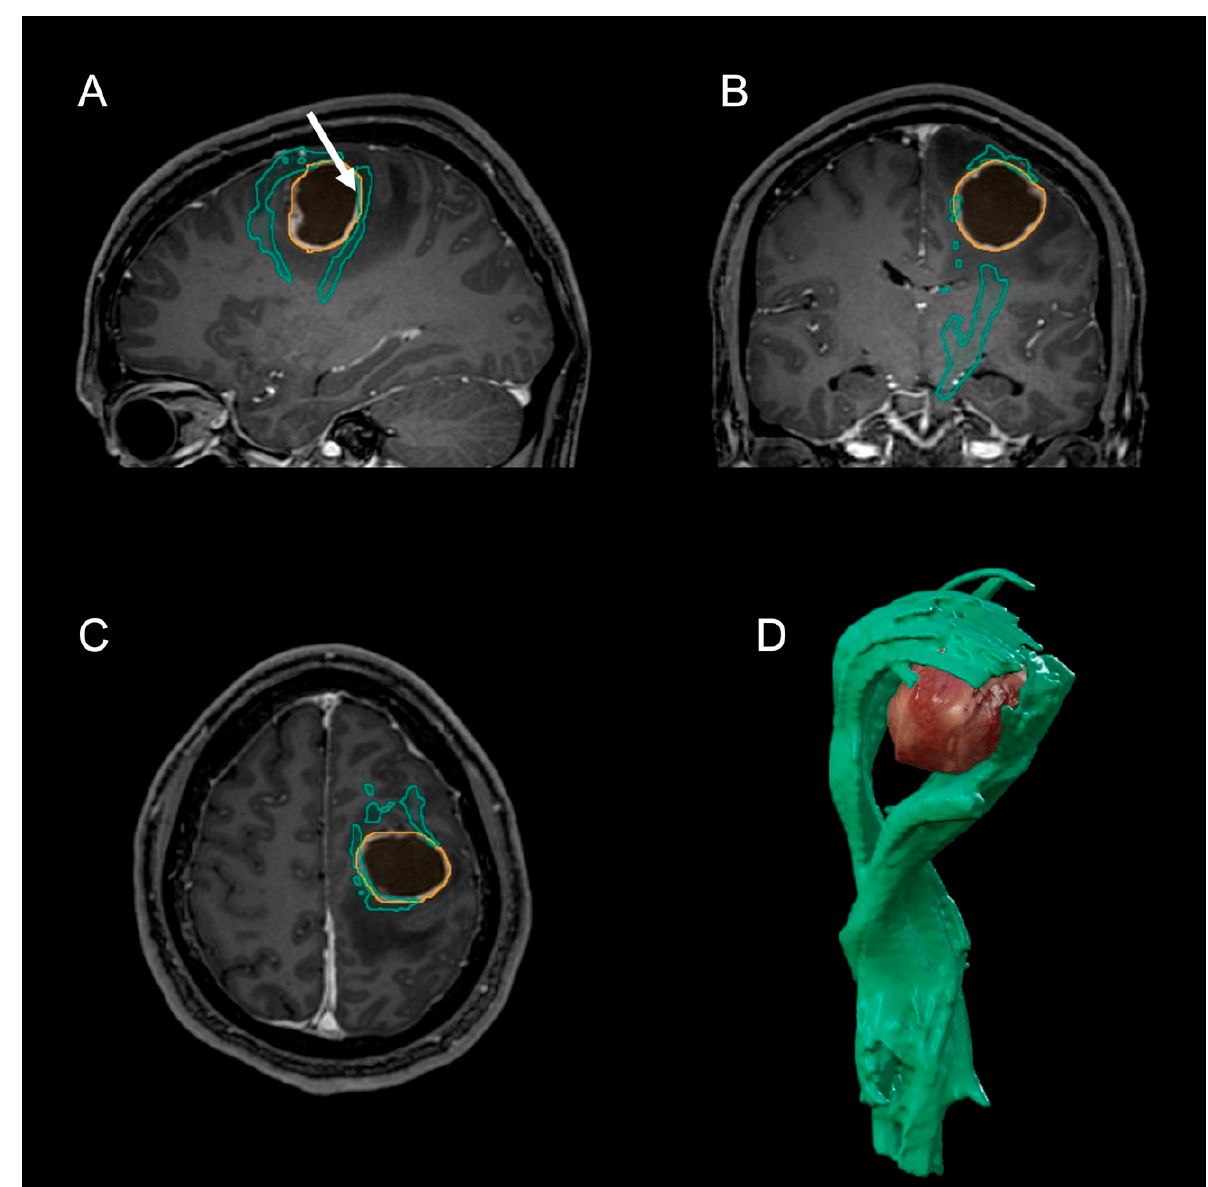
Figure 1. Preoperative MRI in T1 ‐ weighted sequence with contrast enhancement ( A – C ). Arrow: location of positive intraoperative DES at 2 mA. Note the cystic tumor (orange outlines) within the left precentral gyrus. Green outlines: CST. ( D ) Preoperative tractogram of the left CST (green) suggests fibers ventral and dorsal from the tumor. Intraoperative DES revealed primary motor neurons only dorsally. (MRI: magnetic resonance imaging; CST: corticospinal tract; DES: direct electrical stimulation).